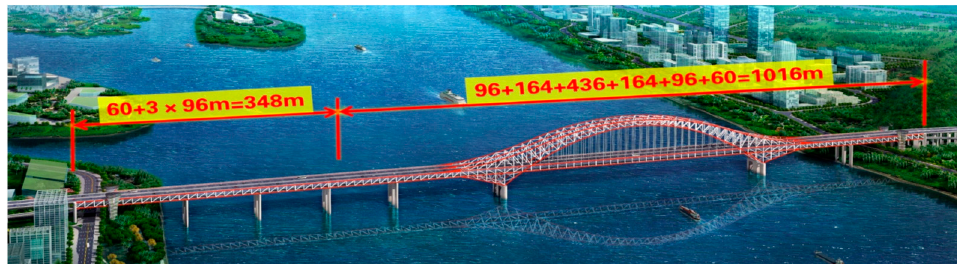
Figure 2. General layout of Guangzhou Mingzhu Bay Bridge.